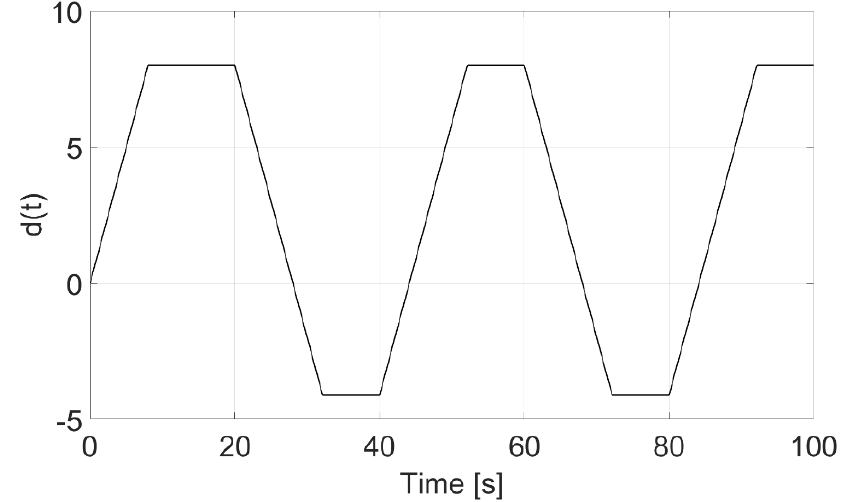
Figure 1. The disturbance acting on the plant.